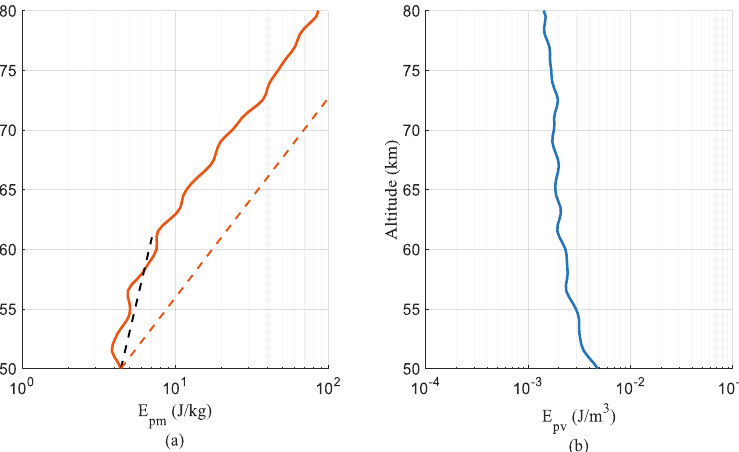
Figure 4. Average profiles of GWPED in 2013 – 2015. ( a ) The red solid line is the E pm profile, the red dotted line is the E pm profile of the conservative AGWs, and the black dotted line is the E pm fitting between 50 – 61 km. ( b ) The E pv profile.